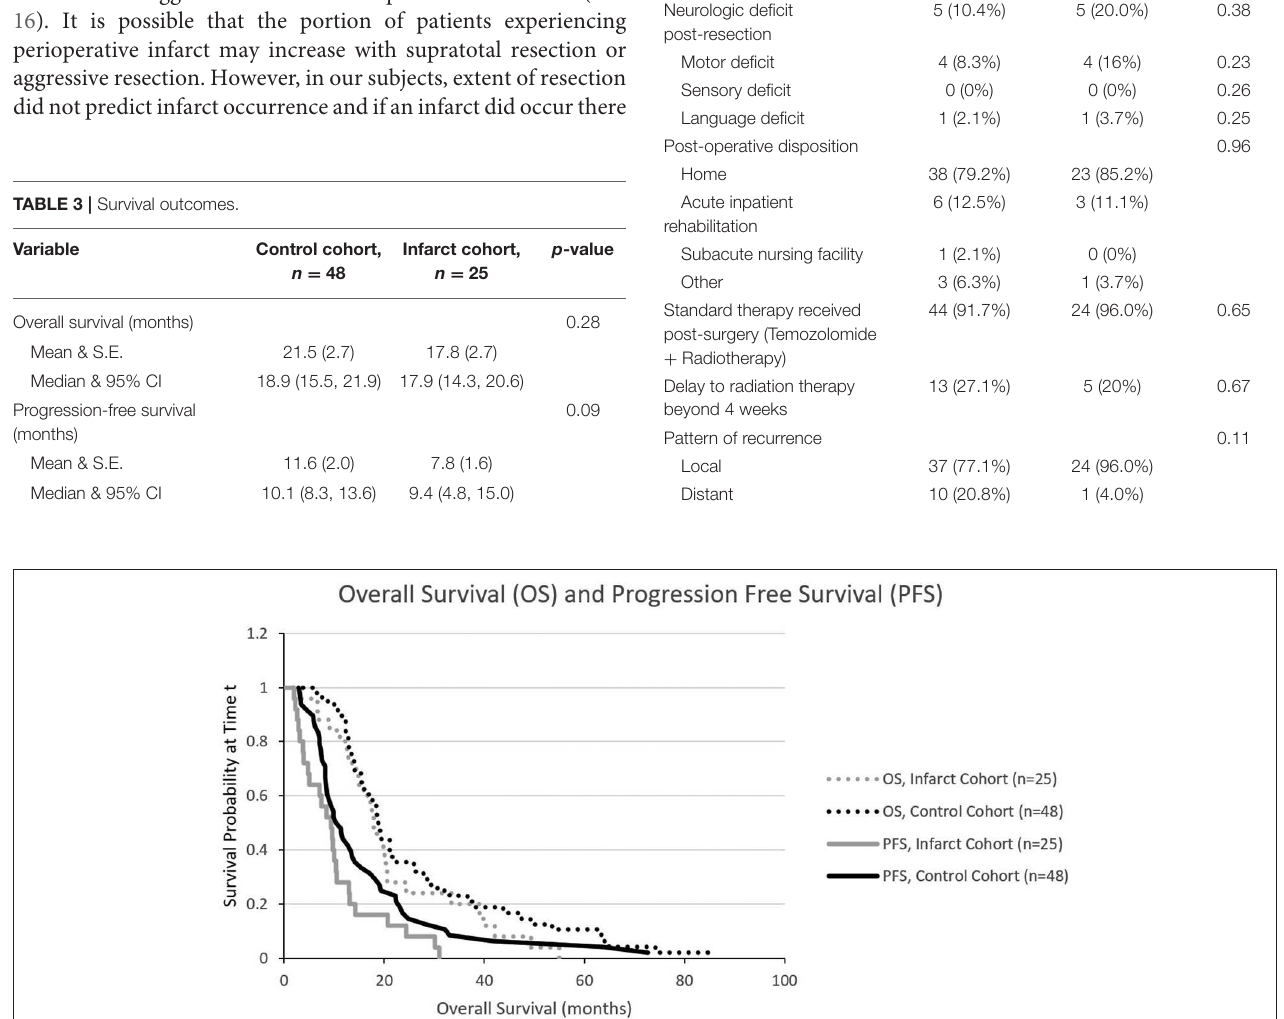
Frontiers in Oncology |